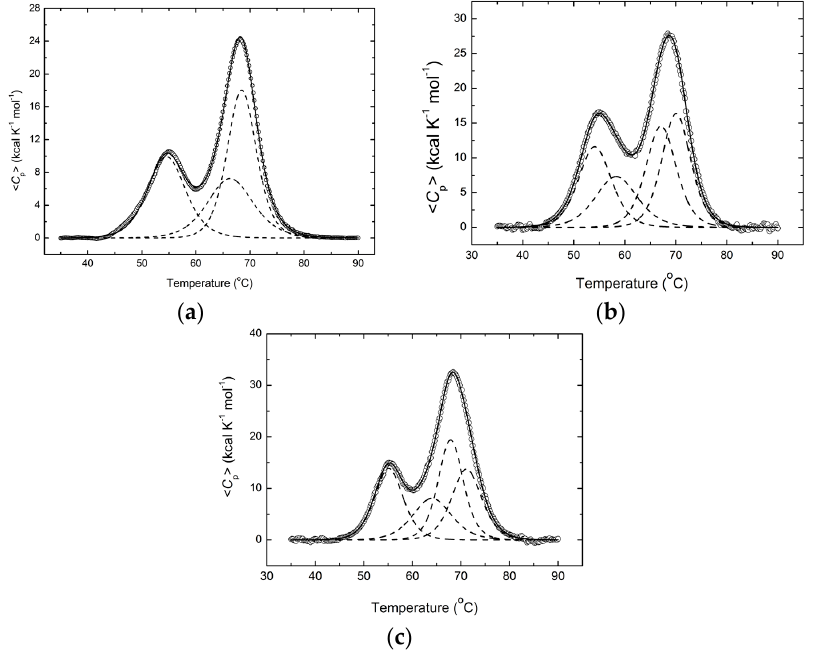
Table 2. Arrhenius equation parameter values for peaks obtained in result of deconvolution of differential scanning calorimetry (DSC) thermograms of HSP70, HSP70/EIII alone and HSP70/EIII + MGDG from Ulva lactuca.